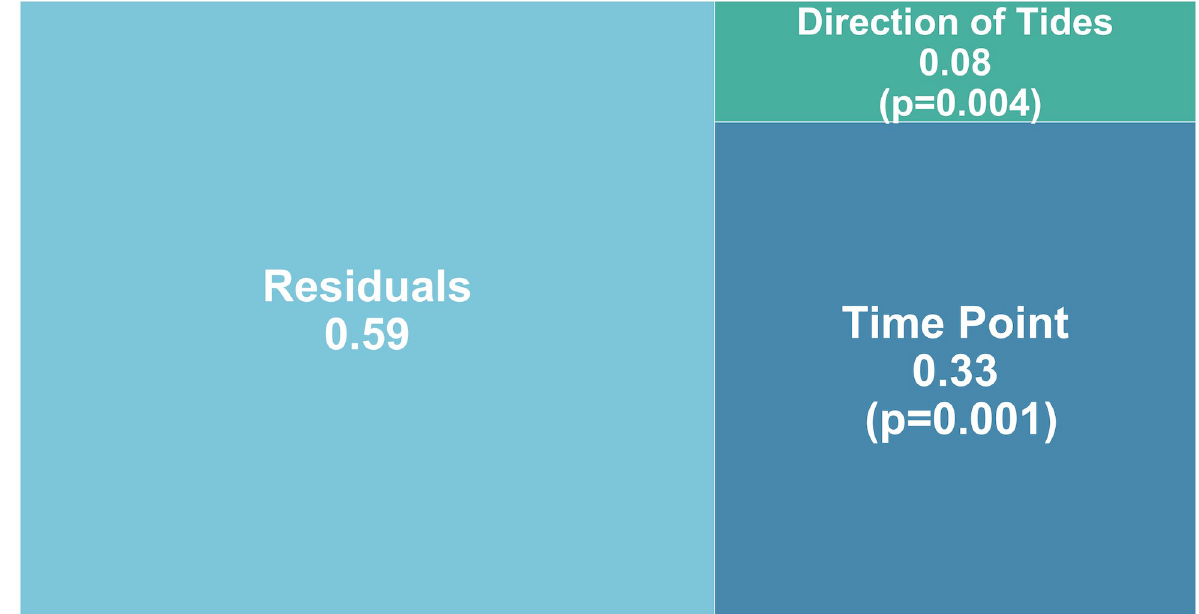
Fig 4. Apportioned variance plot for dock transect from a PERMANOVA with Bray-Curtis dissimilarities. P-values are stated for each factor. The two processes examined are direction of tide (incoming/outgoing/peak) and time point (0–96 hrs).